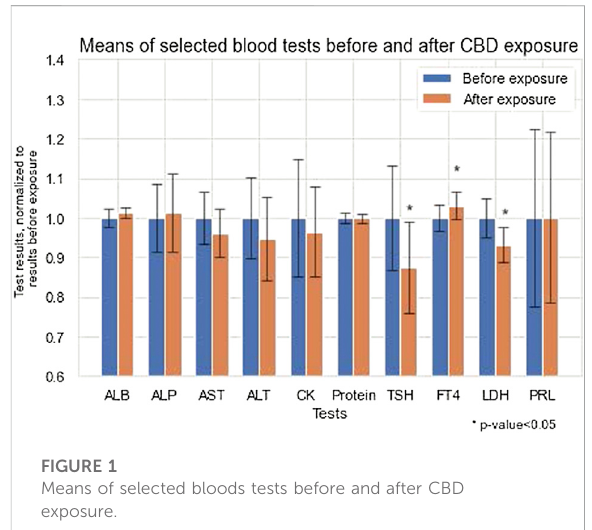
(Supplementary Table S2). The means of selected blood tests before and after CBD exposure is presented in Figure 1.